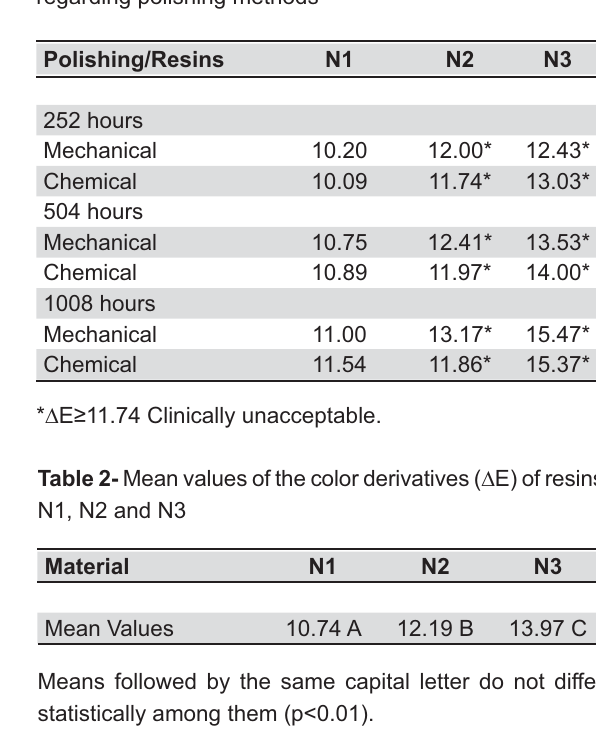
Table 3- (cid:2)(cid:3)(cid:4)(cid:5)(cid:6)(cid:2)(cid:7)(cid:5)(cid:8)(cid:9)(cid:4)(cid:10)(cid:2)(cid:11)(cid:12)(cid:2)(cid:17)!(cid:4)(cid:2)(cid:13)(cid:11)(cid:8)(cid:11)(cid:14)(cid:2)(cid:15)(cid:4)(cid:14)(cid:16)(cid:7)(cid:5)(cid:17)(cid:16)(cid:7)(cid:4)(cid:10)(cid:2)(cid:18)(cid:19)(cid:20)(cid:21)(cid:2)(cid:11)(cid:12)(cid:2) different periods of accelerated aging